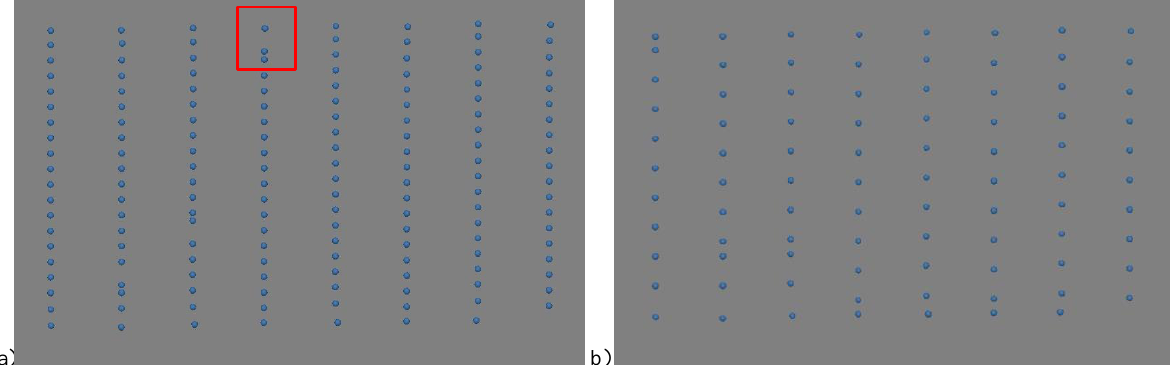
Figure 5. Irregular overlap clearly visible in three consecutive images of the same strip from the Nora dataset (Flight 1).